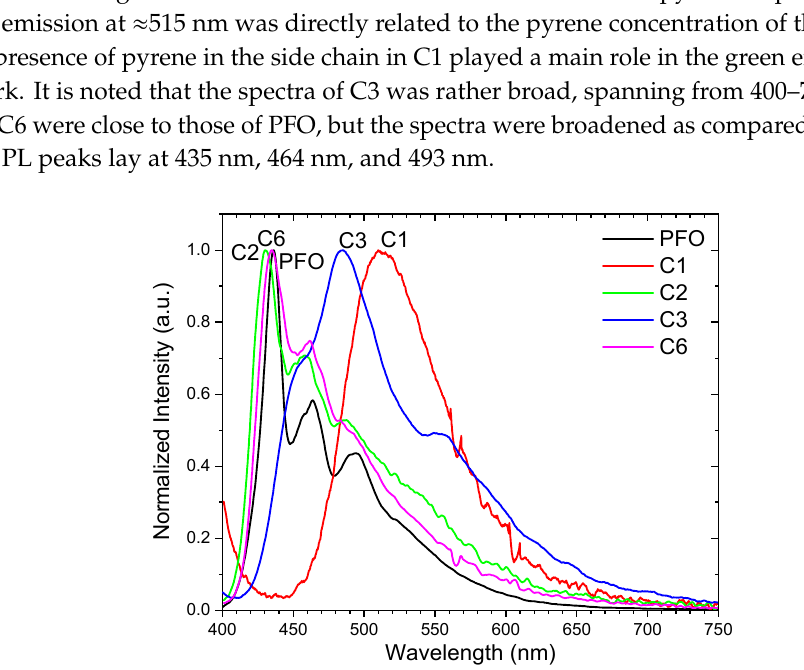
Figure 5. Normalized PL of the polymer films excited using a 368 nm light source.